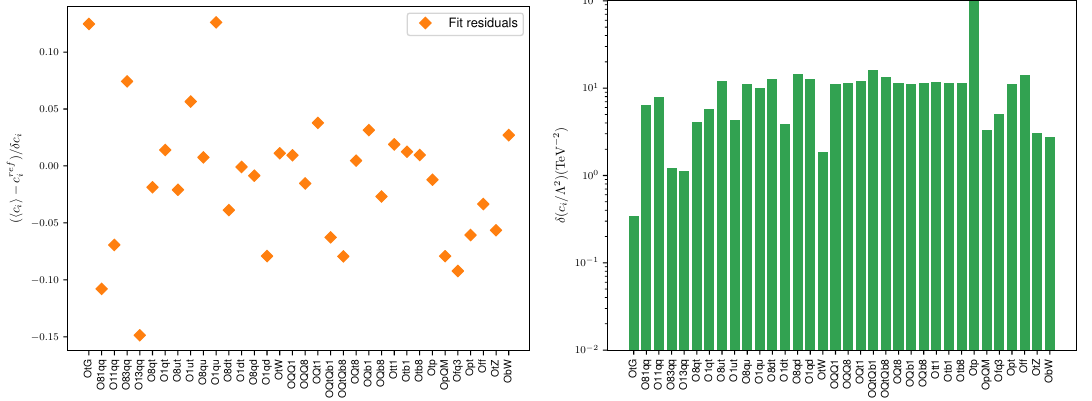
Figure 5 . Left: the (cid:12)t residuals, de(cid:12)ned as in eq. (4.10) for the 34 SMEFT degrees of freedom included in the (cid:12)t for the L0 closure test. Right: the corresponding values of the 95% CL for the (cid:12)t parameters (cid:14)c i . Note that since in general the bounds on each degree of freedom will be rather di(cid:11)erent, this comparison is performed on a log scale.